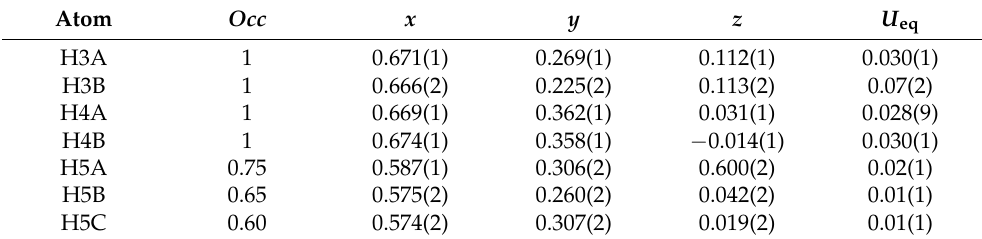
Table 5. Hydrogen atoms coordinates, occupancies (Occ) and displacement isotropic parameters (Å 2 ) for synthetic analogue of natrophosphate at 100 K.